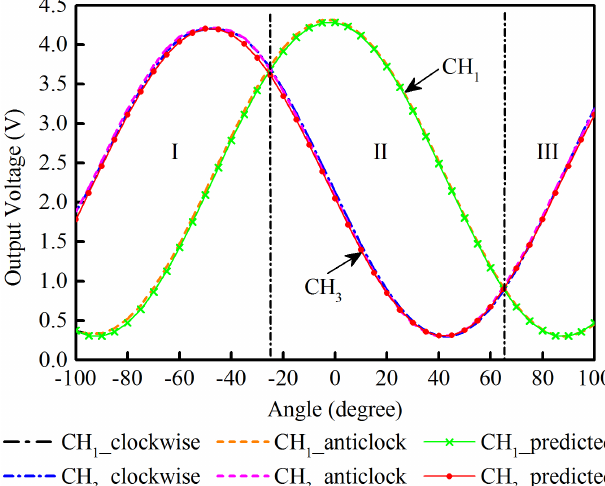
Figure 5. The voltage-to-angle relationships of the sensing channels CH 1 and CH 3 of the optical sensor. CH 1 _clockwise and CH 1 _anticlock represent the outputs of CH 1 when the sensor rotates from − 100 ◦ to 100 ◦ , and then back to − 100 ◦ . CH 1 _predicted is the predicted output value of channel CH 1 . Similarly, CH 3 _clockwise, CH 3 _anticlock, and CH 3 _predicted represent the corresponding readings of CH 3